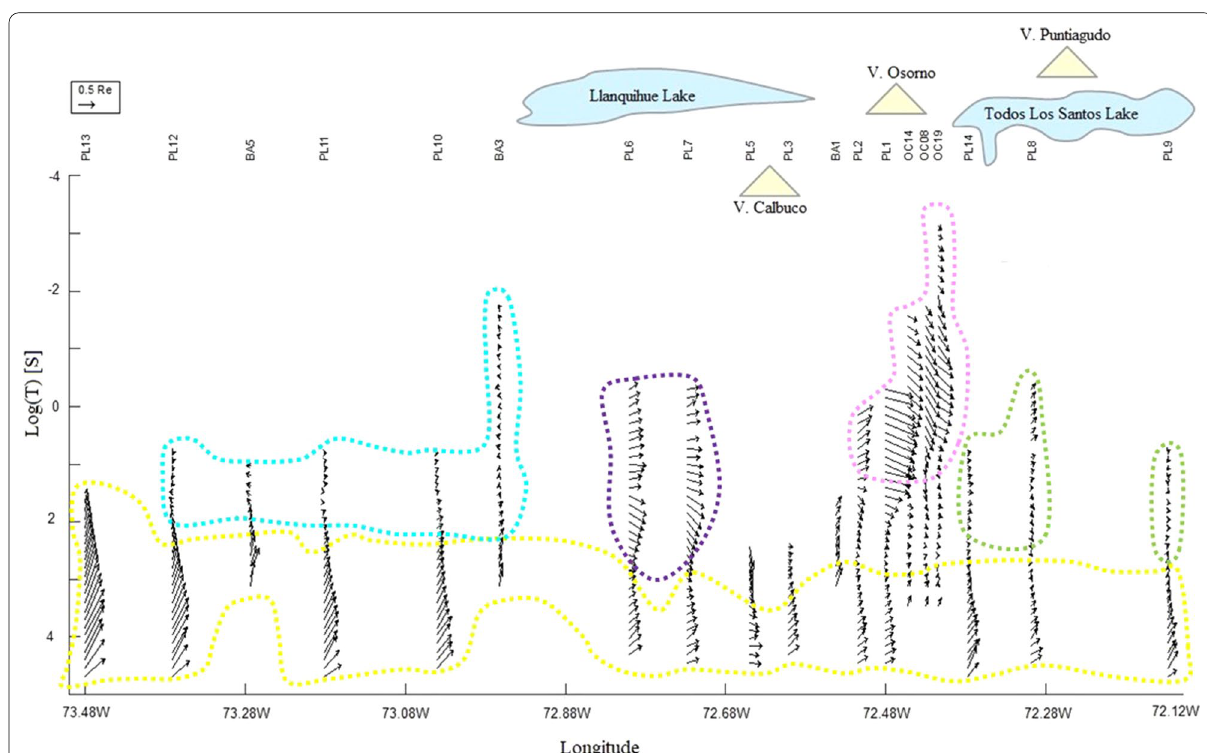
Fig. 3 Induction vectors plotted under the convention of Wiese (1962), the arrows point in the opposite direction of the conductive zone. The vectors enclosed in the yellow box indicate an anisotropic electrical behavior in the crust, the vectors enclosed by the light blue and green zones, because of their magnitude, could indicate data that are within a conductive body and the vectors enclosed in the purple zone indicate a strong conductor to the west area of the profile, the arrows enclosed by the pink line would be related to a conductor in the Osorno